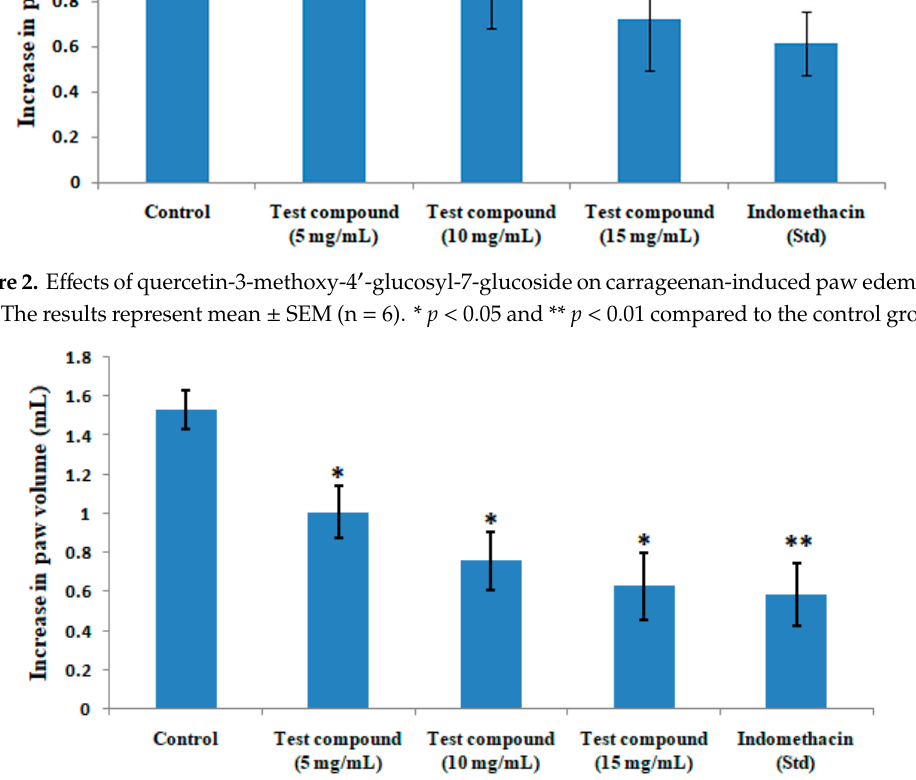
Figure 3. Effects of quercetin-3-methoxy-4 ′ -glucosyl-7-glucoside on dextran-induced paw edema in rats. The results represent mean ± SEM (n = 6). * p < 0.05 and ** p < 0.01 compared to the control group. Table 4. Effect of quercetin-3-methoxy-4 ′ -glucosyl-7-glucoside on cotton pellet-induced granuloma in rats.